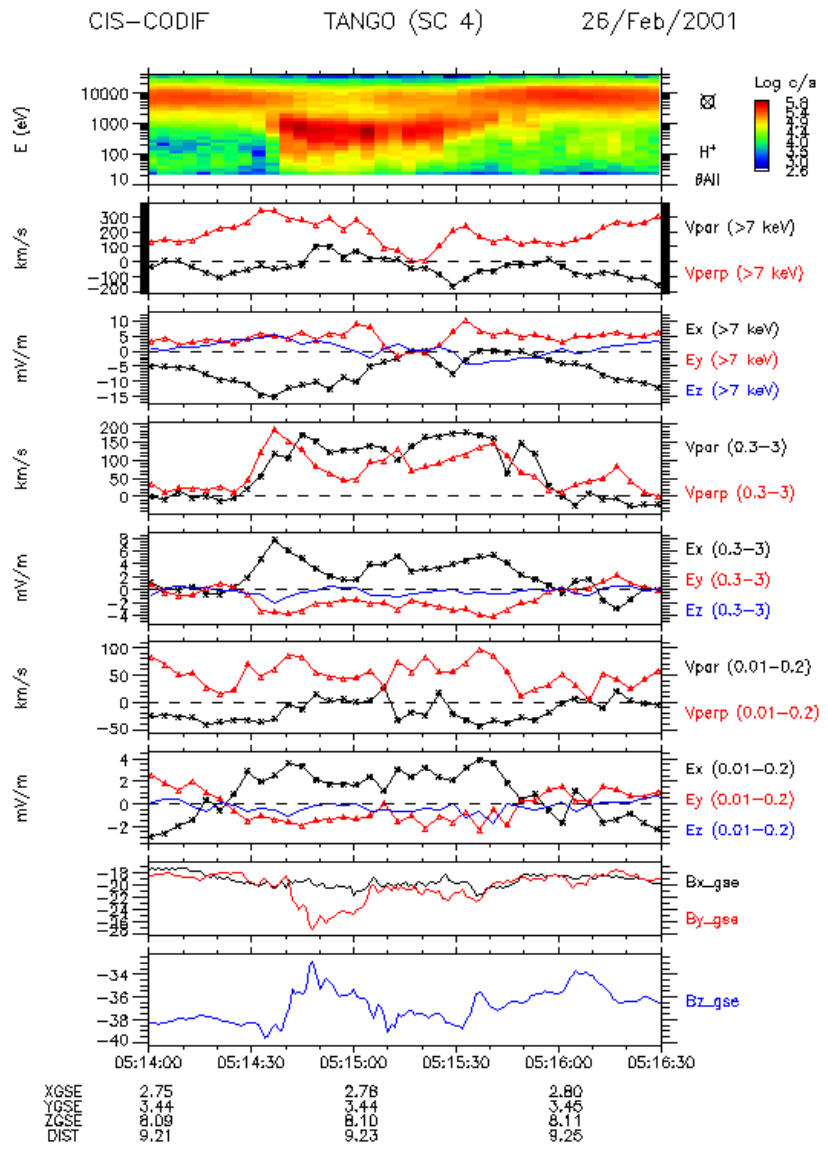
Fig. 8. H + parallel and perpendicular (to B) flow velocities and ( v × B )